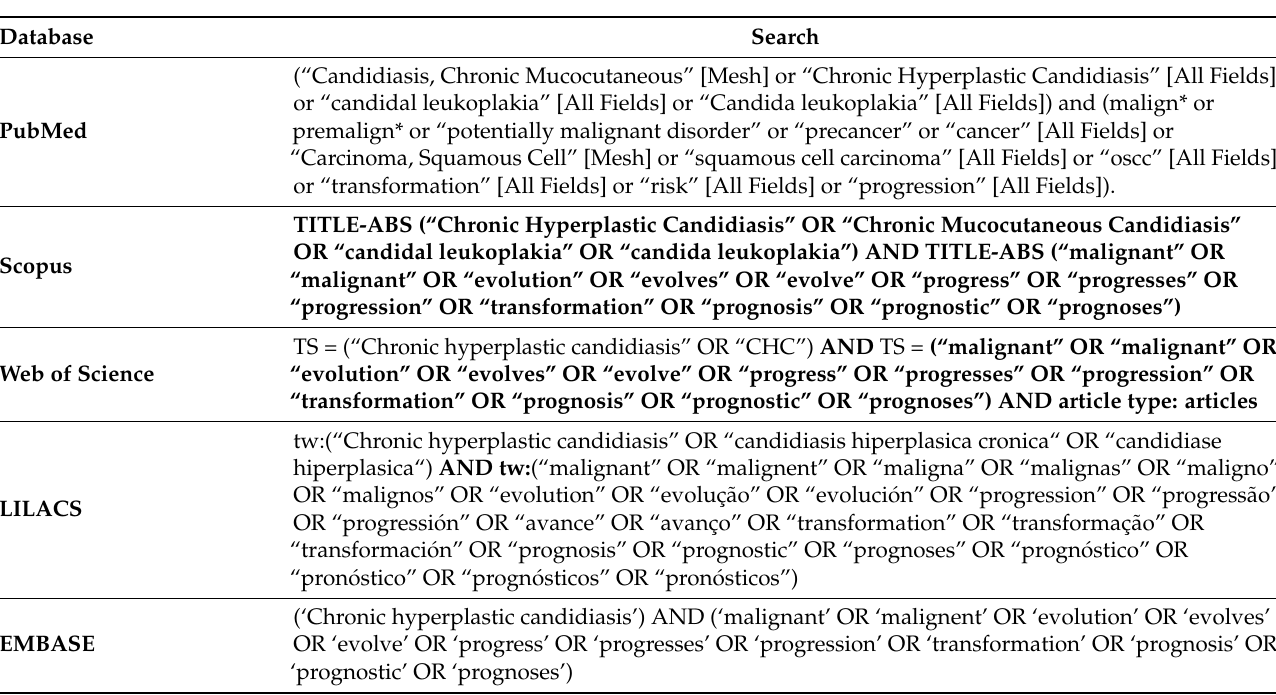
Table A1. Database search strategy (June